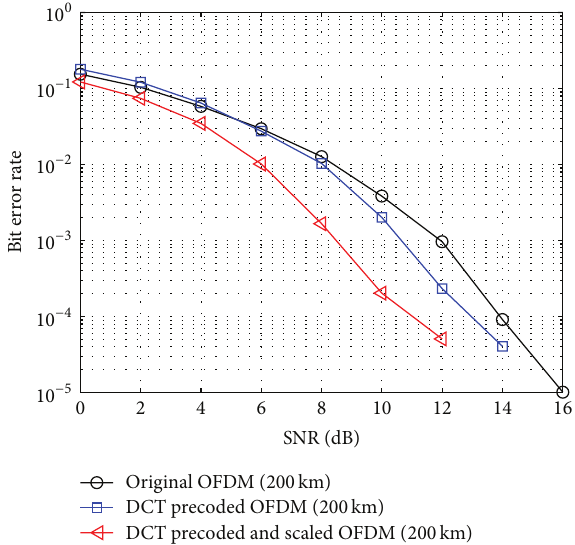
Figure 4: BER performance comparison over 200 km fiber